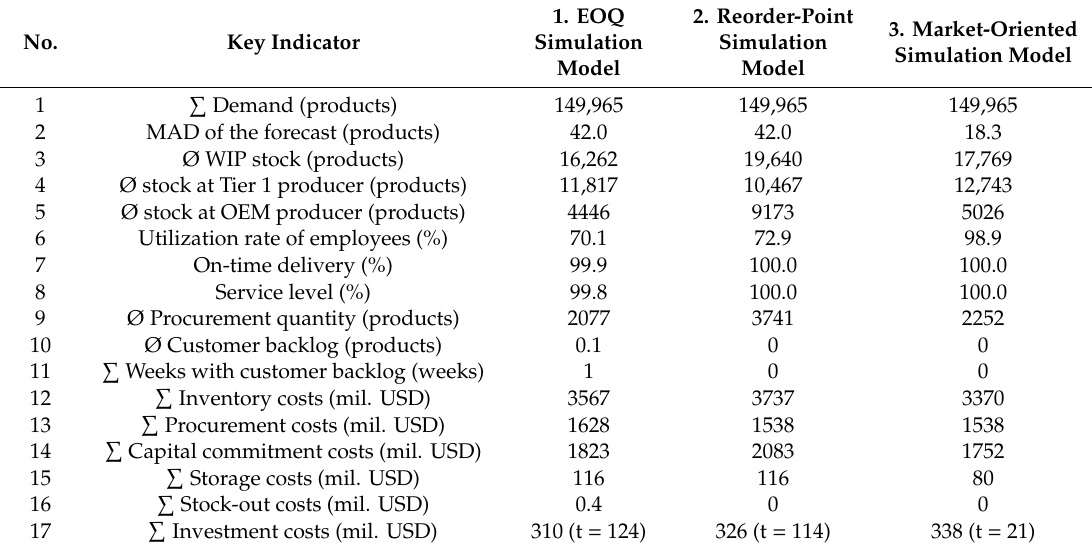
Table 9. Simulation results for the first demand scenario.